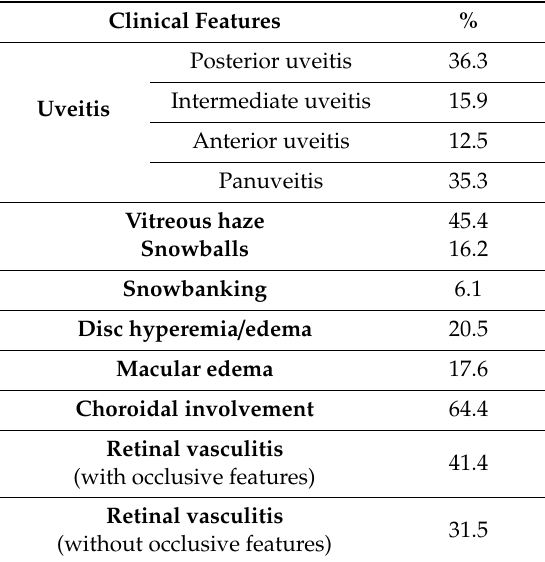
Table 3. Clinical features of